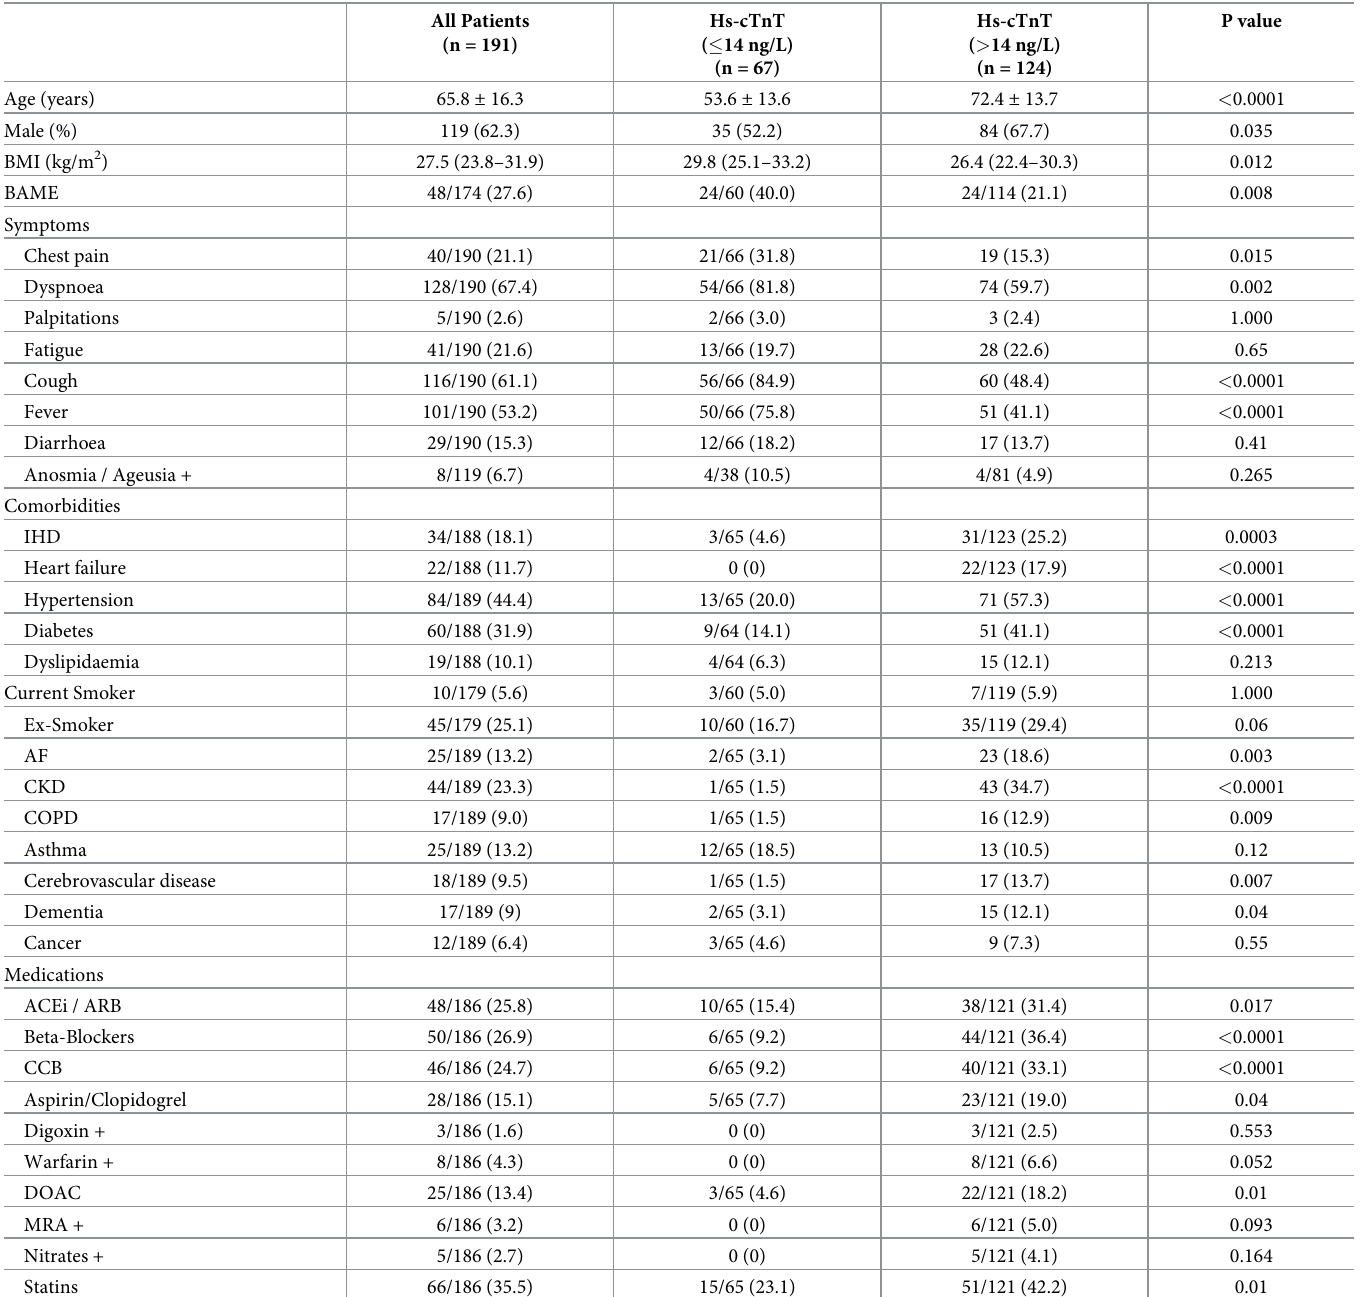
Table 1. Baseline patient